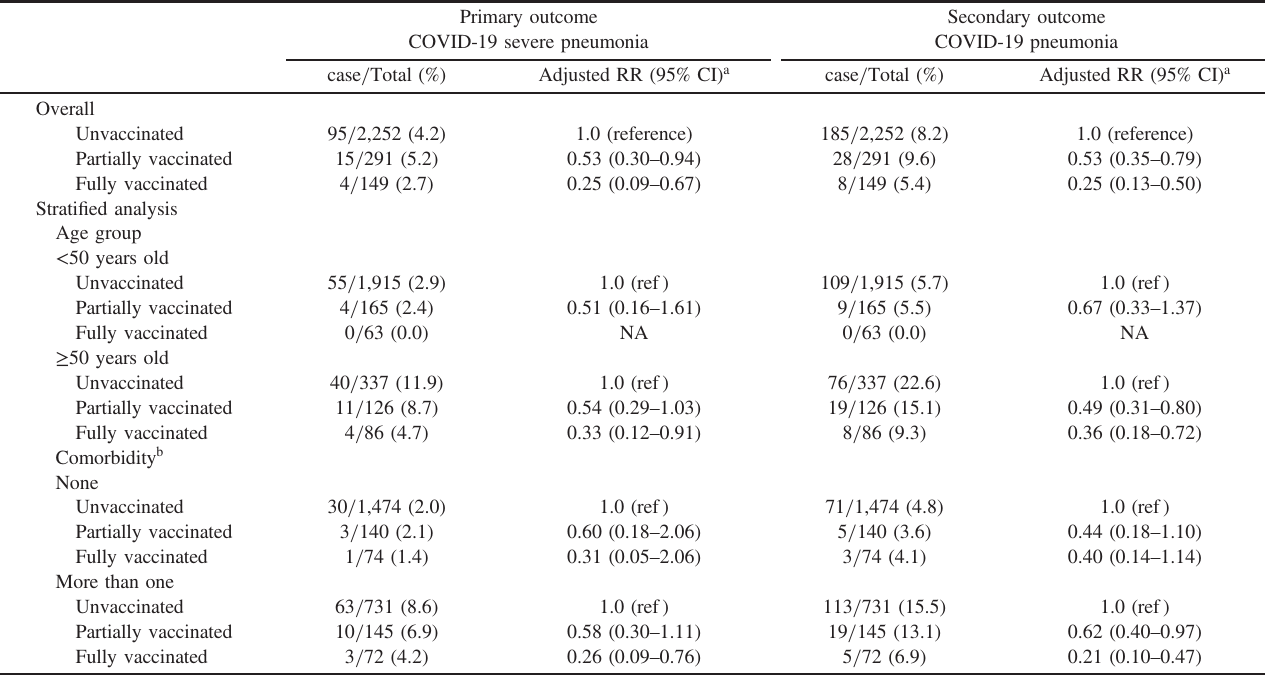
Table 1. E ff ect of mRNA vaccines in preventing COVID-19 severe pneumonia among COVID-19 patients in